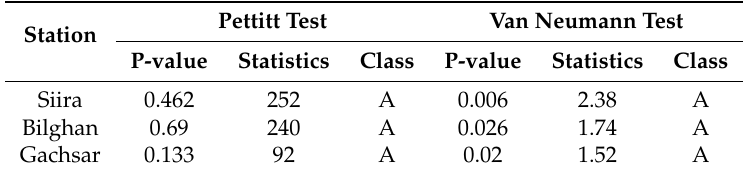
Table 3. Results of homogeneity tests for annual mean streamflow records.